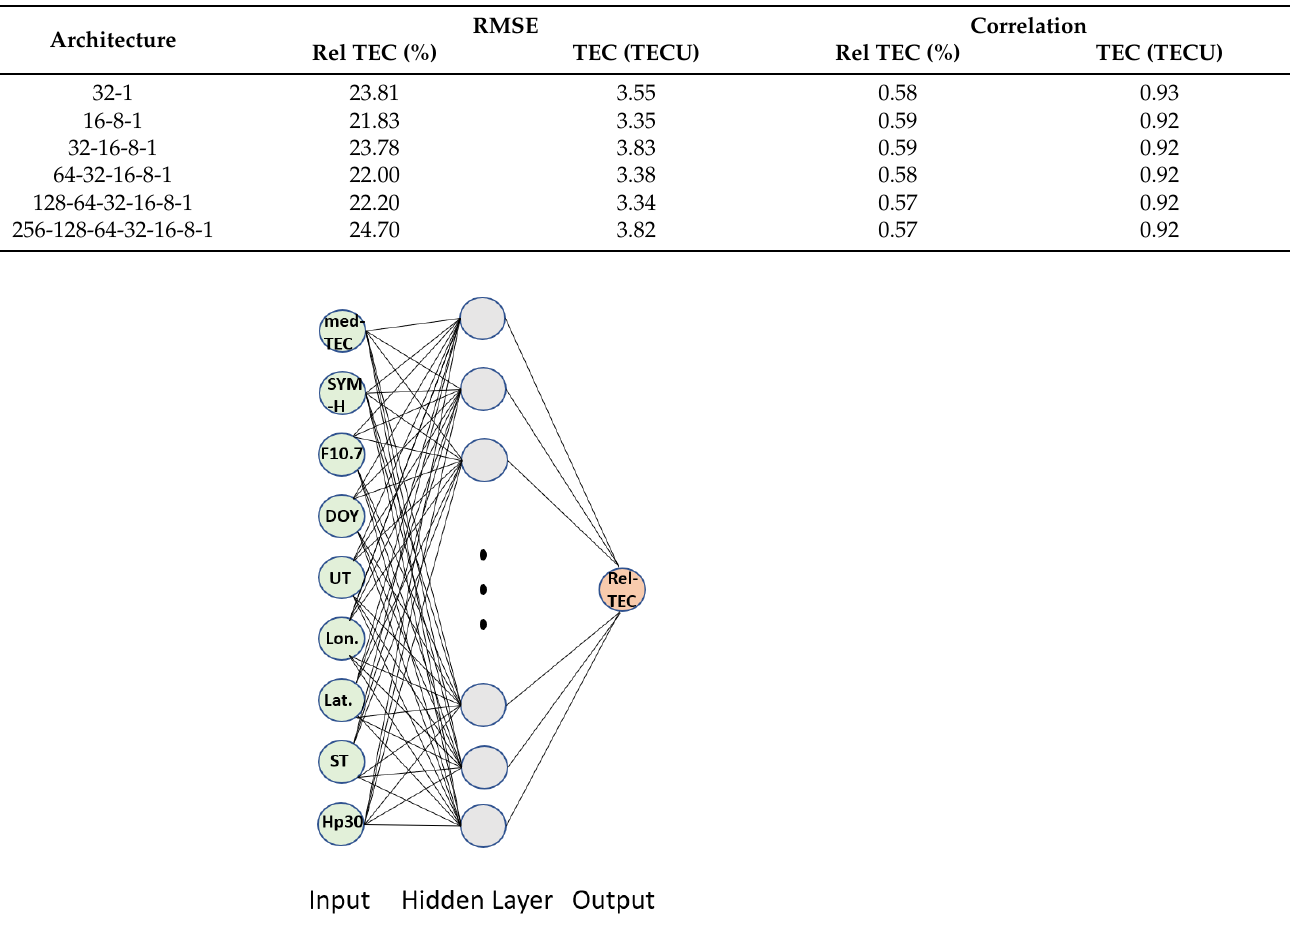
Figure 6. General overview of the neural network (NN) architecture where ST stands for the storm time and med-TEC for the 27-day median of the preceding days before the